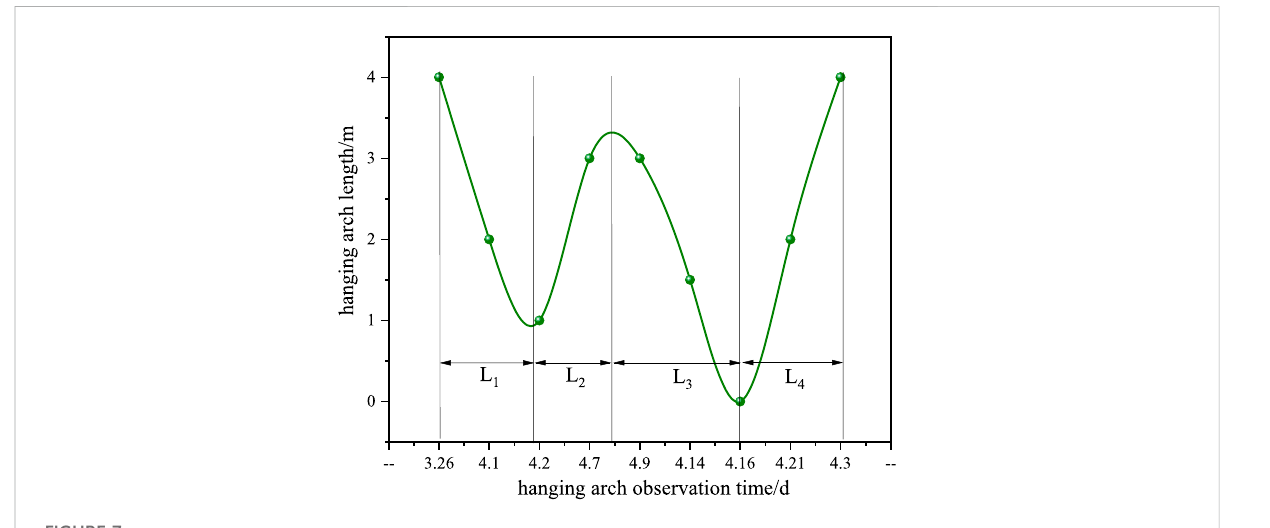
FIGURE 7 Changing curves of suspended ceiling length during